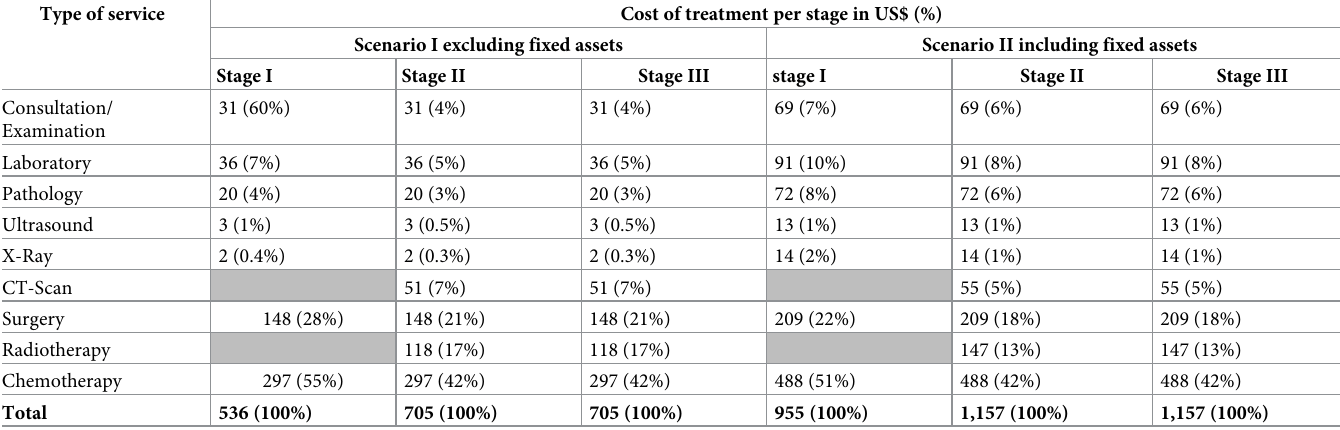
Table 3. Unit cost for treatment by breast cancer stage (April 21,